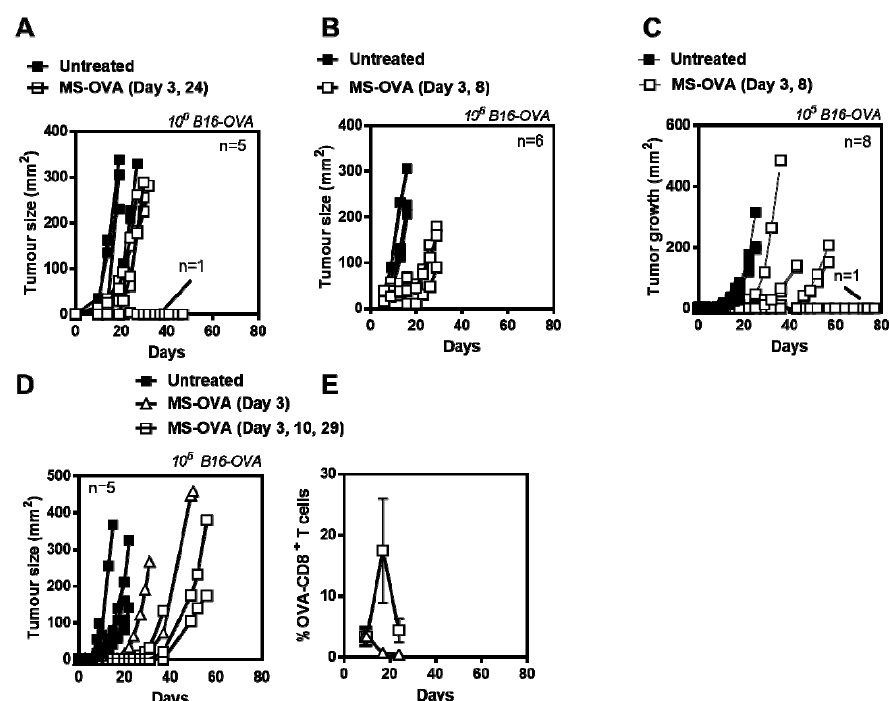
Figure 2. Optimizing MS-OVA treatment. C57BL/6 mice were given 10 6 B16-OVA tumor cells s.c. in the dorsal flank, MS-OVA was given s.c. at the base of the tail on ( A ), day 3 and 24 or ( B ) day 3 and 8, and tumor growth was measured over time. Alternatively, a reduced number of tumor cells, 10 5 of B16-OVA, were injected followed by MS-OVA treatment on ( C ) day 3 and 8, ( D ) day 3, or day 3, 10 and 29, and tumor growth was measured. The mean frequency ± SD of OVA-CD8 + T cells was compared in mice treated with MS-OVA on day 3 vs. days 3, 10, and 29 ( E ).